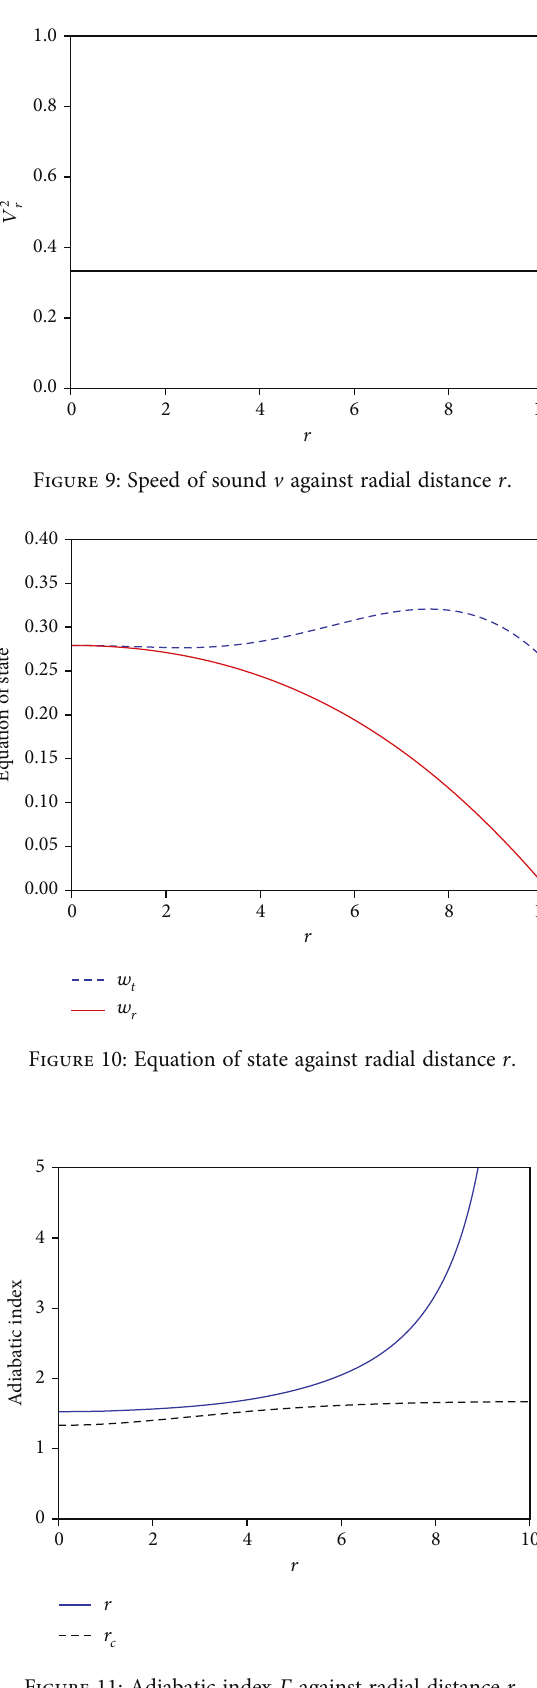
Figure 11: Adiabatic index Γ against radial distance r .